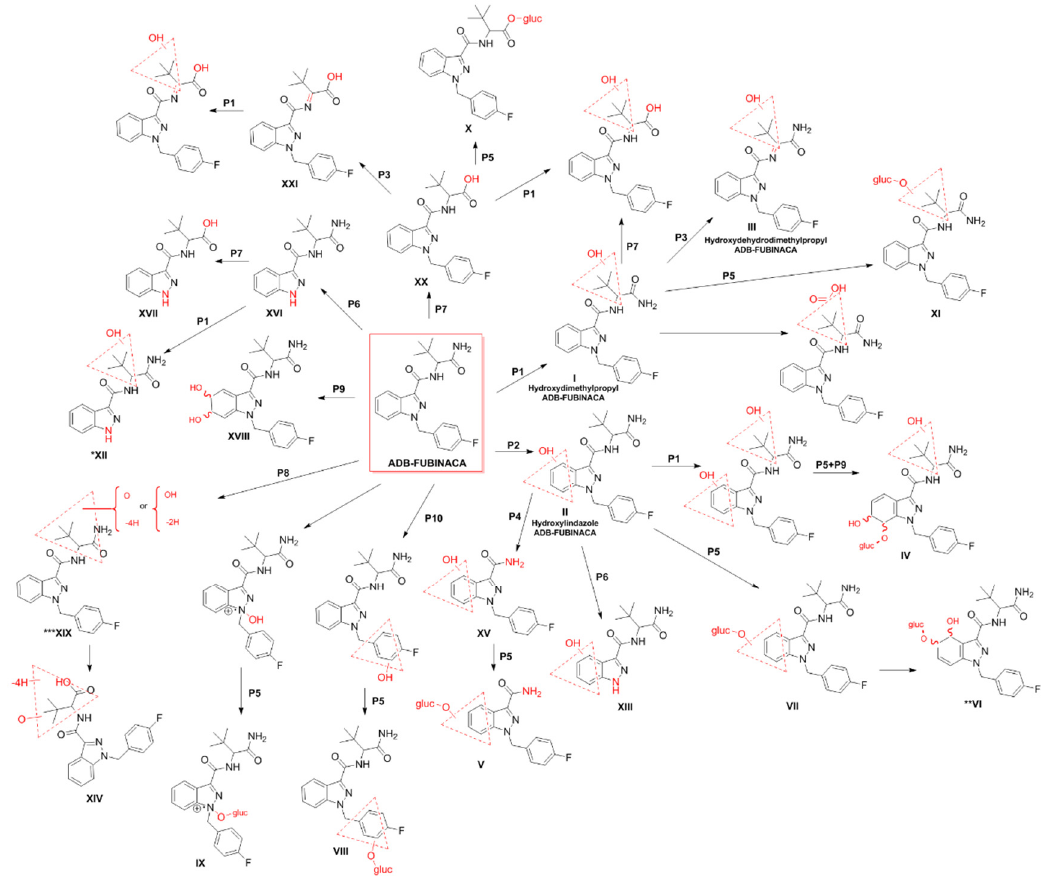
Figure 3. Metabolic pathways of ADB-FUBINACA in humans [38,52]. The main biotransformation pathways include alkyl (P1) or indazole ring hydroxylation (P2), dehydrogenation (P3), secondary amide hydrolysis (P4), and glucuronide conjugation (P5). Other metabolic pathways are N -dealkylation (P6), primary amide hydrolysis (P7), carbonylation (P8), epoxidation followed by hydrolysis (P9), and methylene-fluorophenyl hydroxylation (P10). Dashed red triangles represent the location at which the reaction supposedly occurs. *XII is also a metabolite resulting from the N -dealkylation of I. **VI is formed by further hydroxylation of ADB-FUBINACA hydroxyindazole-glucuronide on the benzene ring. ***XIX is formed by hydroxylation and a di-dehydrogenation on the amino-dimethylbutanamide moiety.